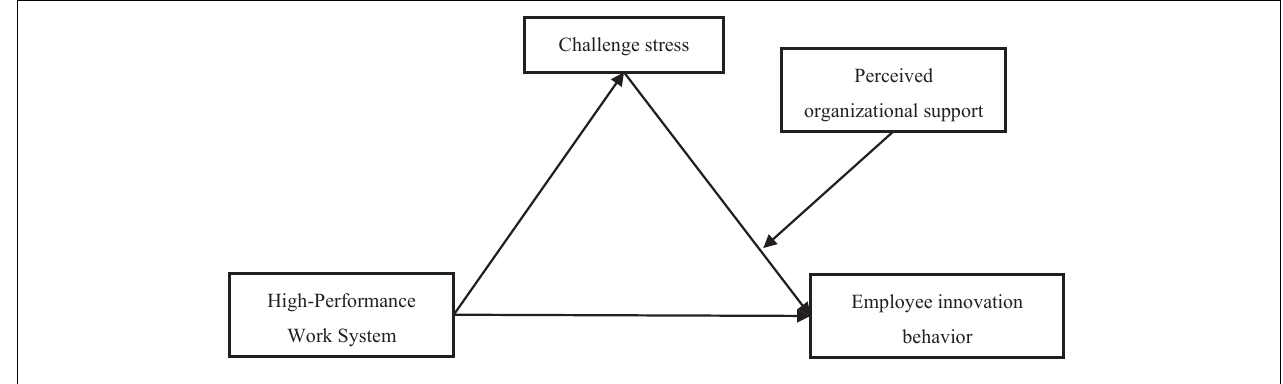
FIGURE 1 | The research framework of this